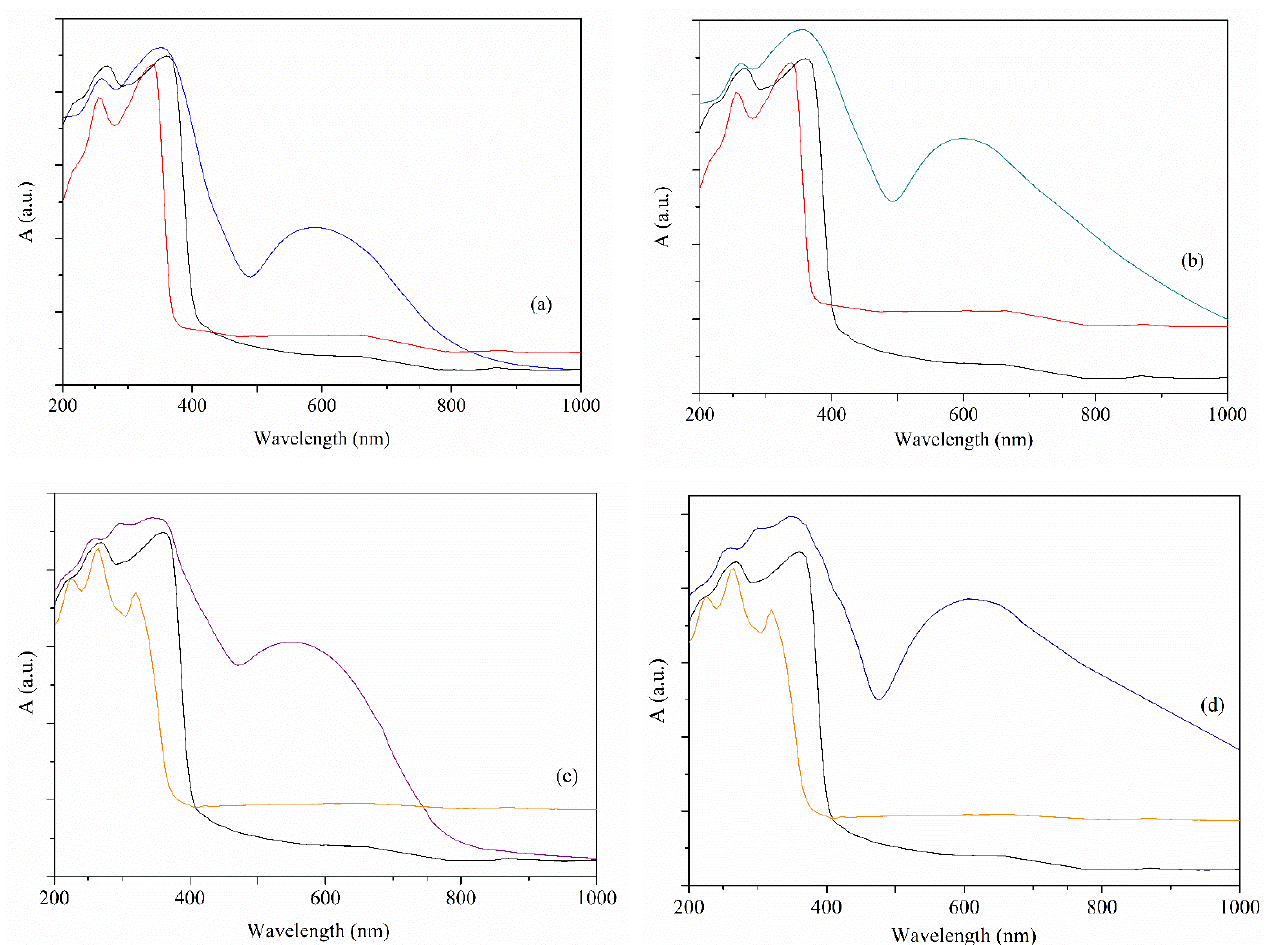
Figure 4. The UV-Vis spectra of ( 1 ) (blue line, Hbzac-black line, phen-red line) ( a ), ( 2 ) (blue line) ( b ), ( 3 ) (purple line, bpy-orange line) ( c ), and ( 4 ) (blue line) ( d ). Solution EPR Spectroscopy The Cu(II) complexes were dissolved in DMSO at a final concentration of 1